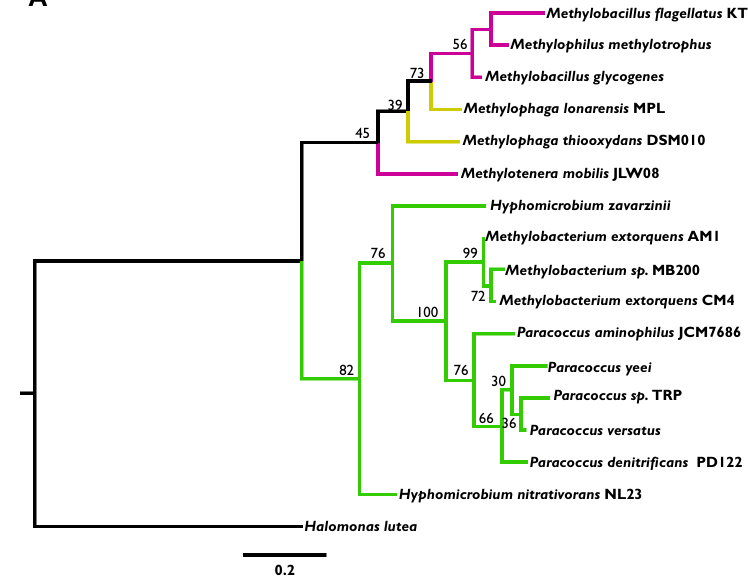
Figure 3. A maximum likelihood phylogeny of the gmaS amino acid sequence (encoding the first enzyme of the N- methylglutamate pathway) from sequenced methylotrophs of the Alpha—(green), Beta—(pink), and Gamma—(yellow) Proteobacteria using the gmaS sequence from Oceanobacter kriegii as the outgroup. Numbers adjoining nodes represent bootstrap support. Figure